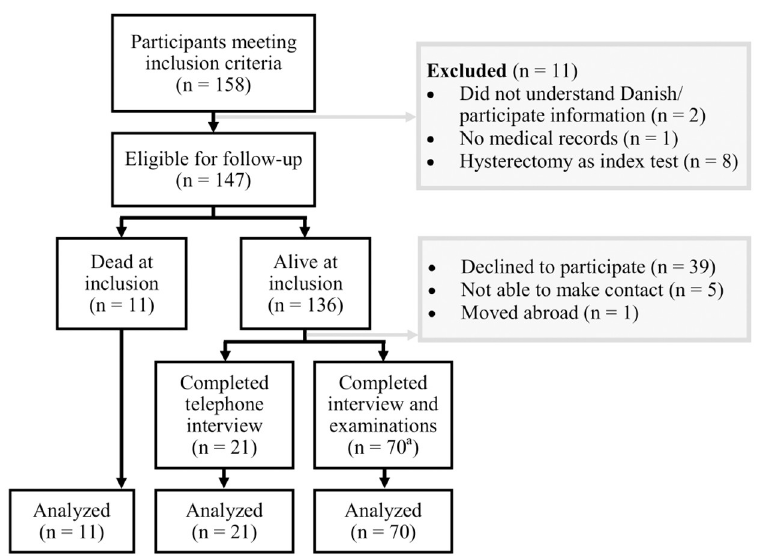
Fig 1. Participant flow chart. Index test = initial histological sample with non-atypical endometrial hyperplasia between 2000–2015. a) One woman did not want to participate in office mini-hysteroscopy, but she completed the transvaginal ultrasound and the